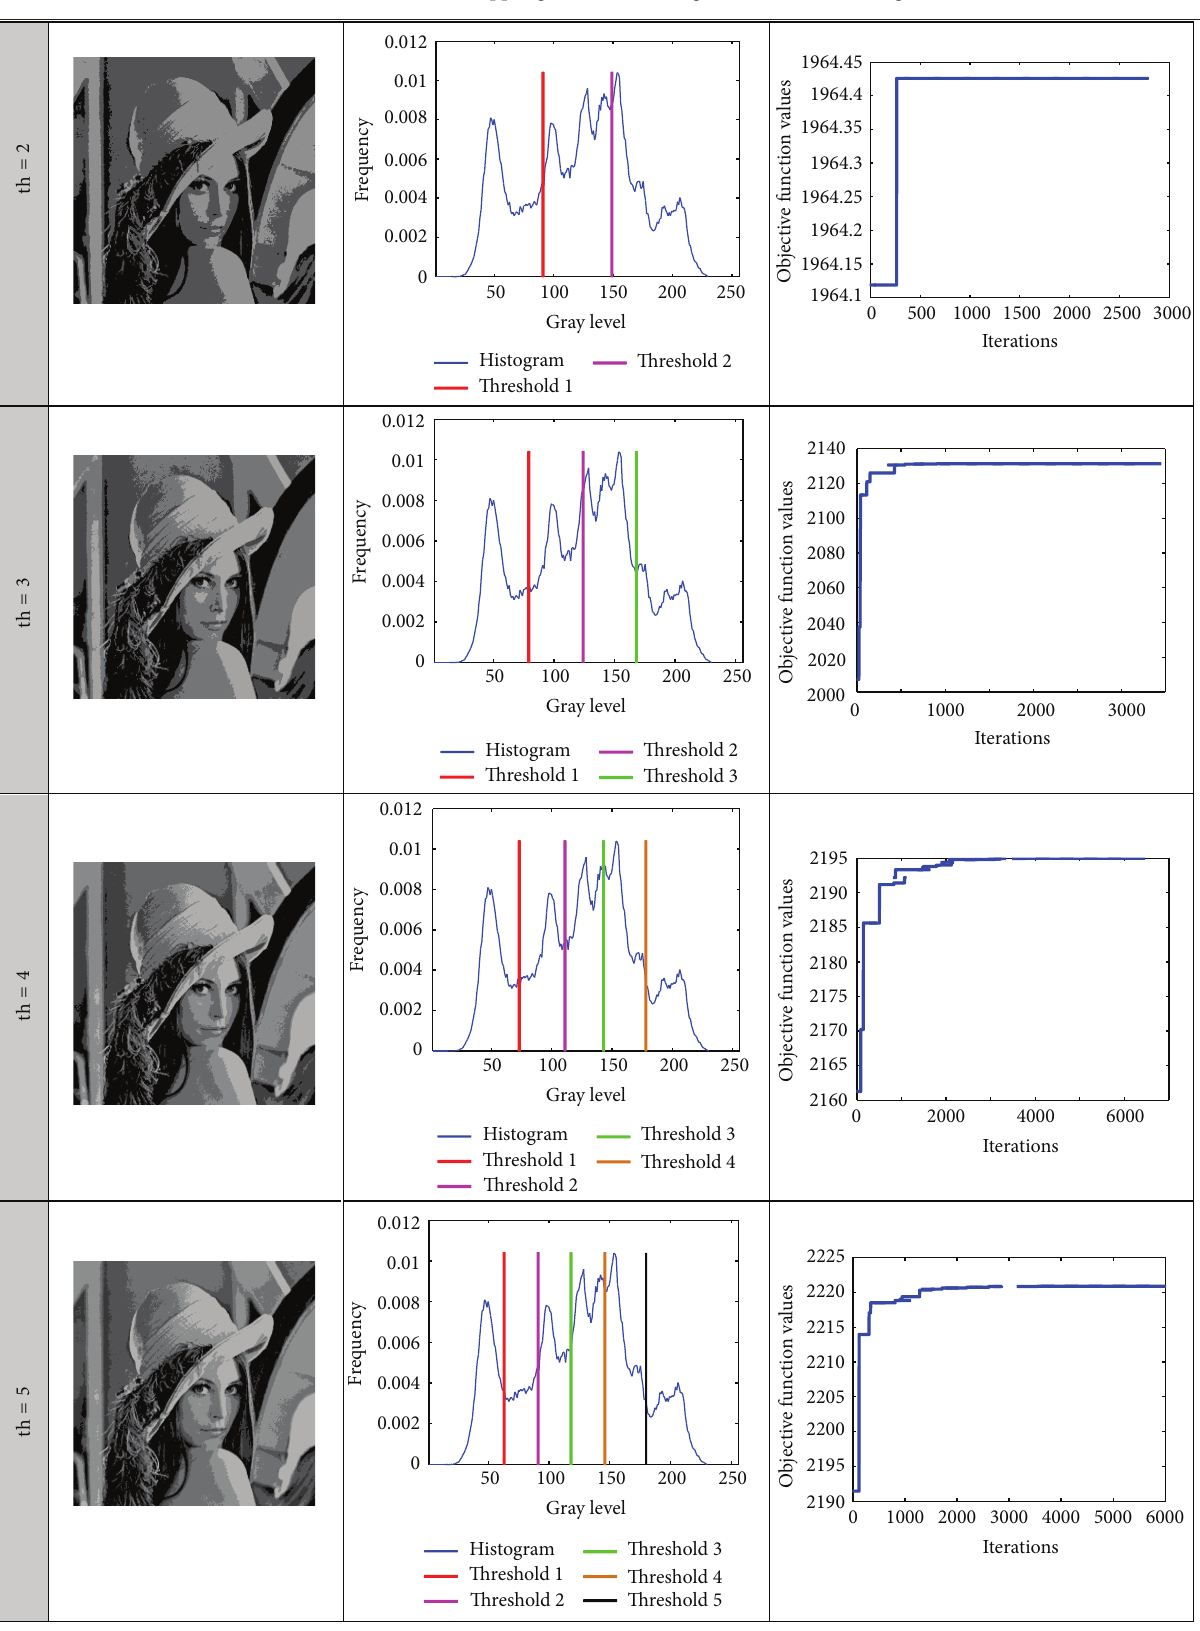
Table 5: Results after appling the HSMA using Otsu’s over Lena